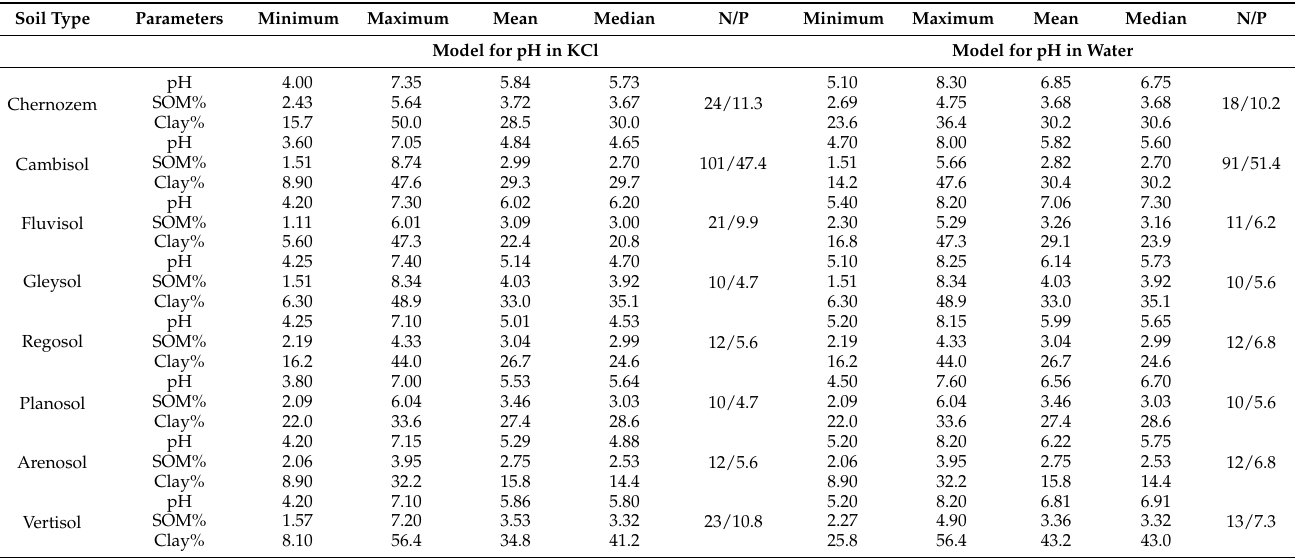
Table 2. Descriptive statistics for the basic physicochemical properties of the soil samples tested by type of soil: Minimum, Maximum, Mean, Median, N (number of soil samples tested) and P (percentage of the soil type in the sample) for model 3–12. Soil Type